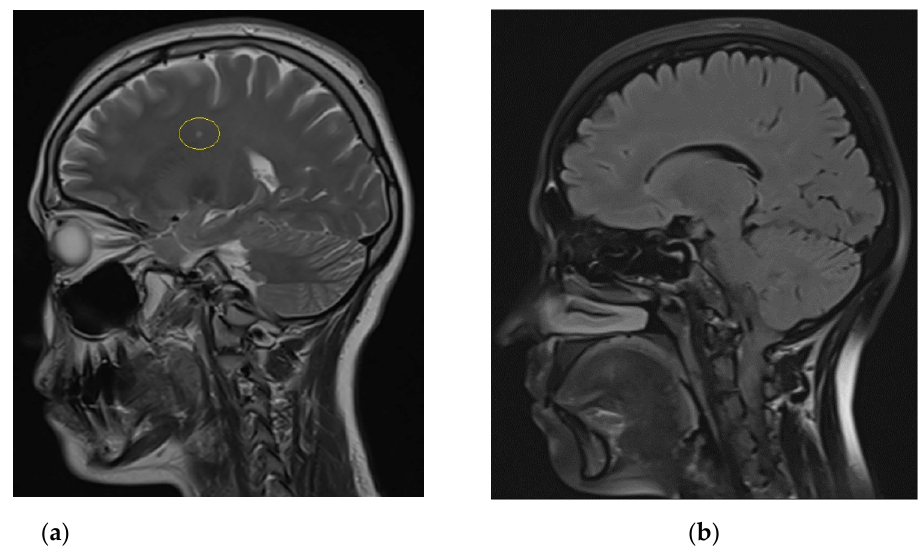
Figure 1. ( a ) Sagittal T2-weighted MRI scan of the brain shows active foci of demyelination in the left frontal lobe (yellow circle); ( b ) Sagittal T2 TIRM dark fluid MRI scan shows moderate tongue muscle atrophy.